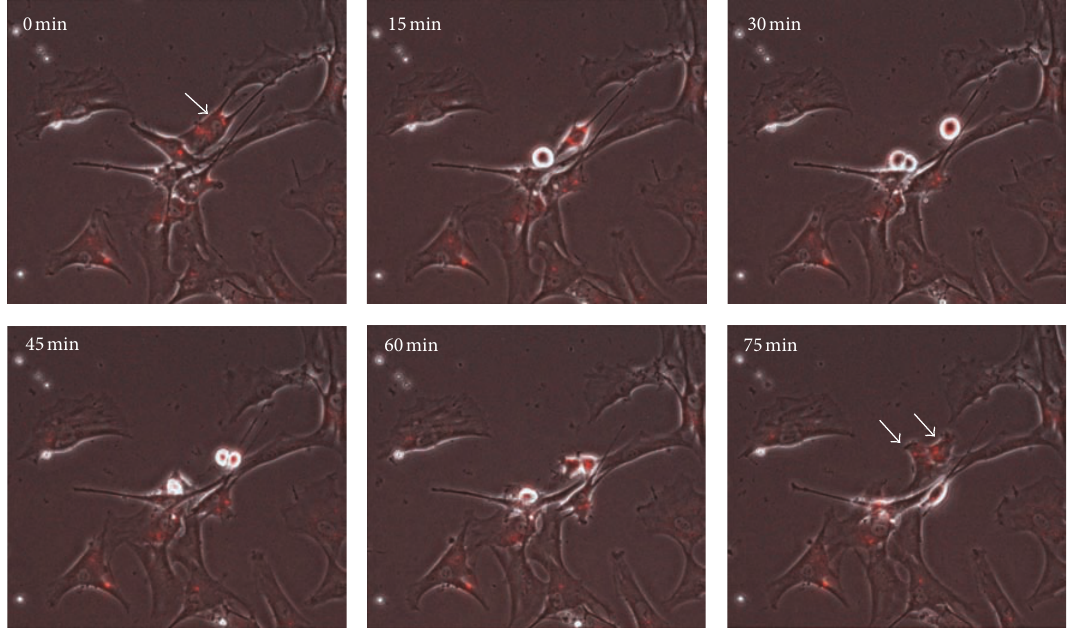
Figure 5: Time-lapse study showing equal passing on of QDs during cell division (see arrows). Selected microscopy images acquired during cultivation of labeled cells show a time period of 75 min. Overlay images were created from the fluorescent and the phase contrast image.